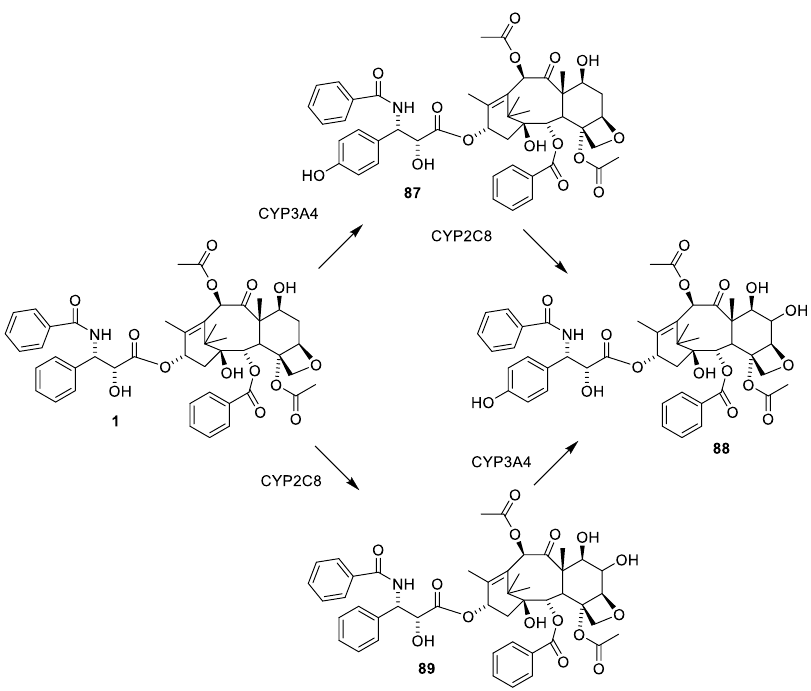
Figure 24. Dominant metabolism of paclitaxel by liver cytochrome P450 enzymes CYP2C8 and CYP3A4 [84].